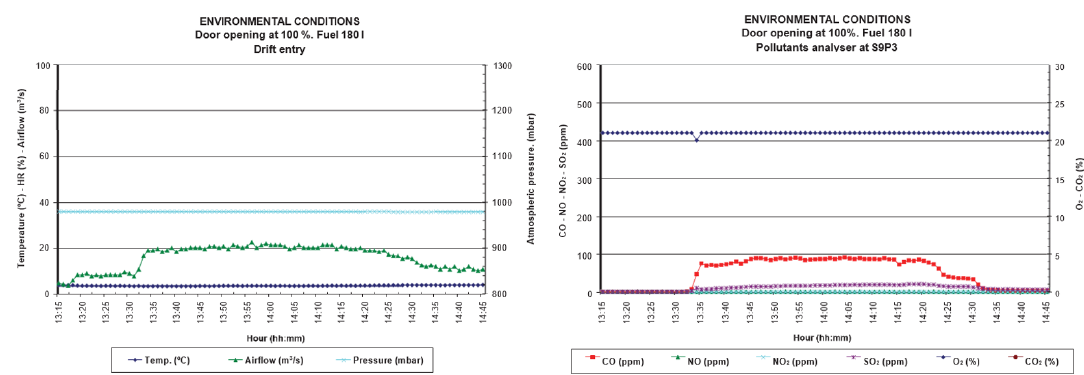
Figure 7. Evolution of the environmental conditions over time; test 3.